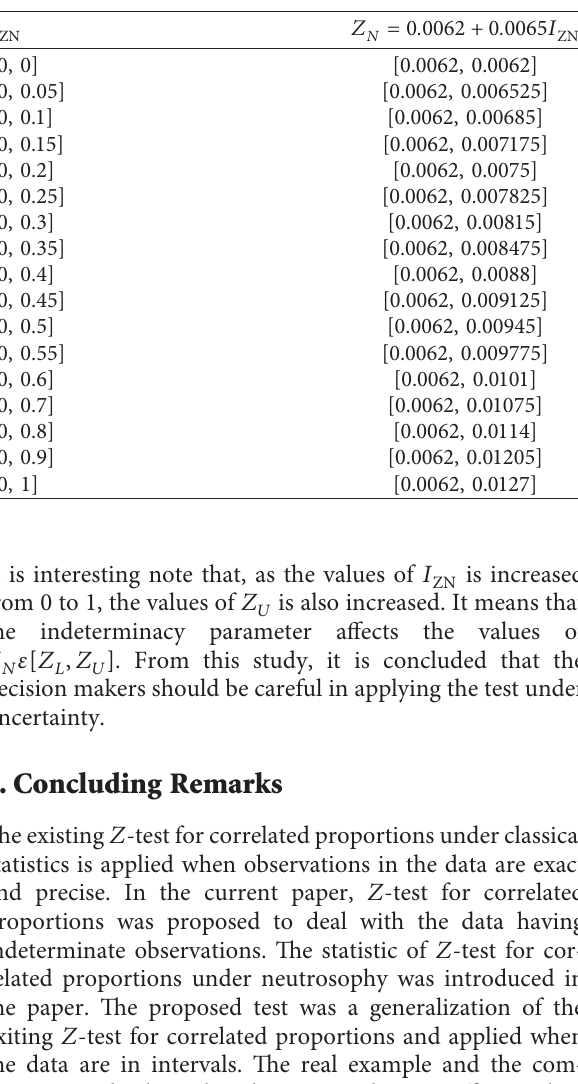
Table 5: Simulation